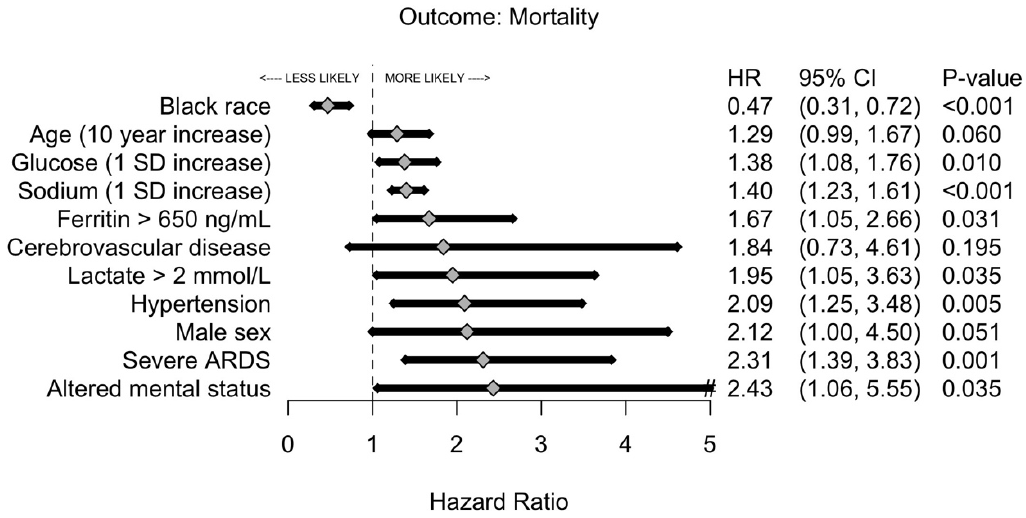
Figure 4. Likelihood of mortality of patients with critical COVID-19 pneumonia by risk factors. The forest plot analysis is a multivariable logistic regression with cluster-robust standard errors that was selected using a forward and backward stepwise selection procedure based on overall model likelihood. Abbreviations: ARDS, acute respiratory distress syndrome; COVID-19, coronavirus disease 2019.